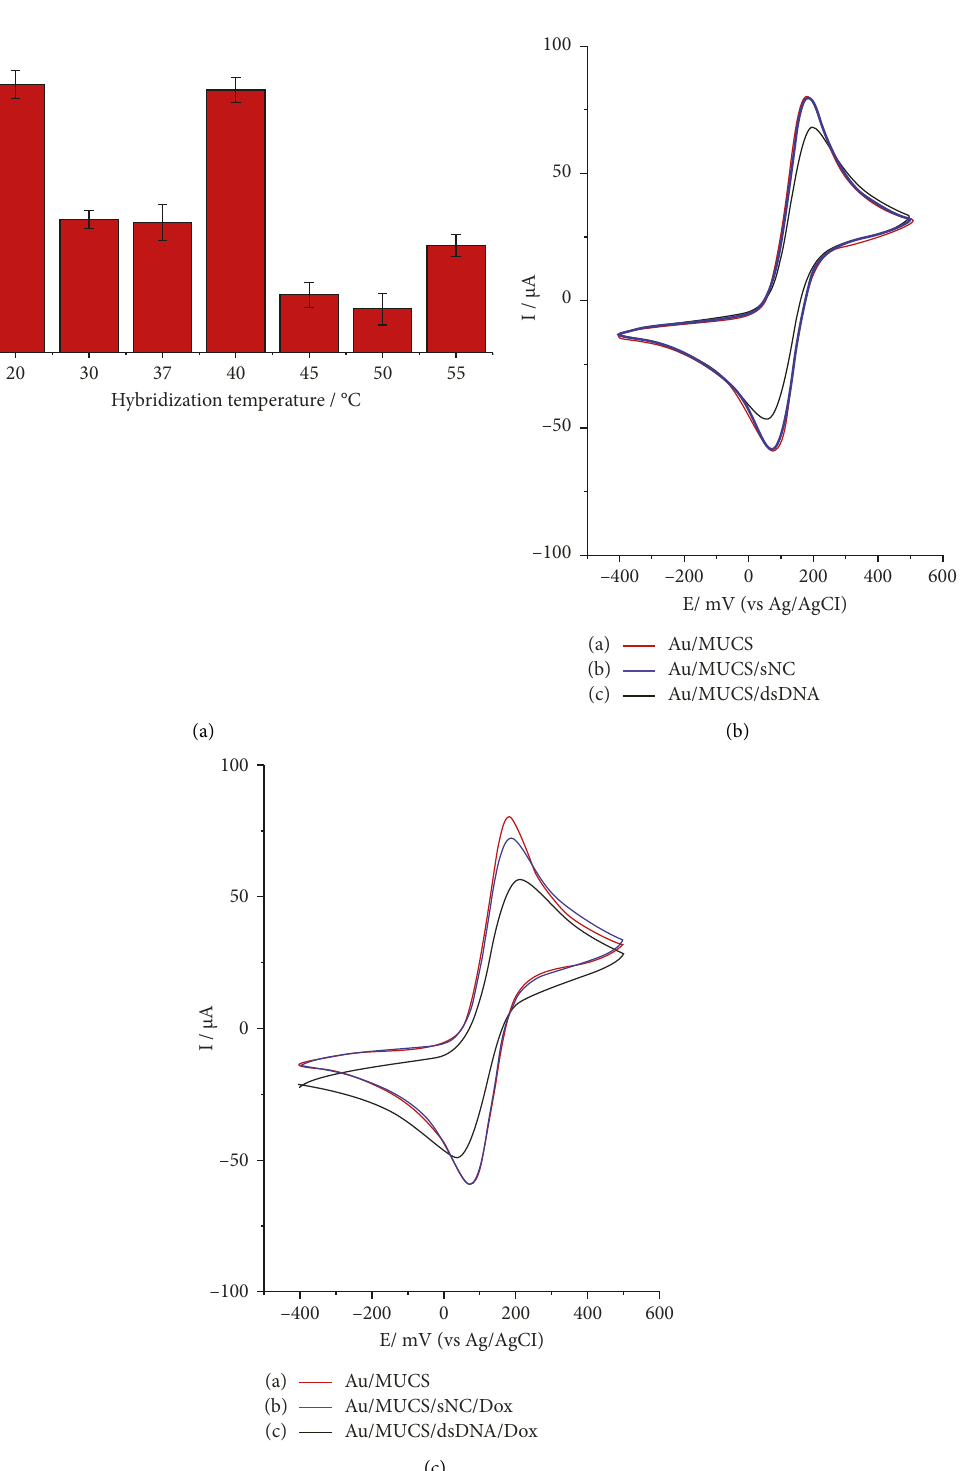
Figure 4: (a) The relative current change of the anodic peak of [Fe(CN) − 3/ − 4 redox probe versus hybridization temperature after the dox 6 ] treatment, at the room temperature (20 ° C) (Au/MUCS/dsDNA/dox). (b) Cyclic voltammograms of [Fe(CN) 6 ] 3 − /4 − redox probe recorded at Au/MUCS electrode (a), Au/MUCS/sNC electrode (b), and Au/MUCS/dsDNA electrode (c). (c) Cyclic voltammograms of [Fe(CN) 6 ] 3 − /4 − redox probe recorded at Au/MUCS electrode (a) Au/MUCS/sNC/dox electrode (b), and Au/MUCS/dsDNA/dox electrode. The dox solution was added in excess 10 − 5 (M) all electrochemical measures were made by means of cyclic voltammetry (CV) at a scan rate of 50mV/s, within a potential range from − 400 mV to